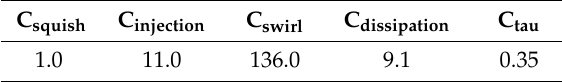
Table 5. Calibrated constants for the k- ε turbulence